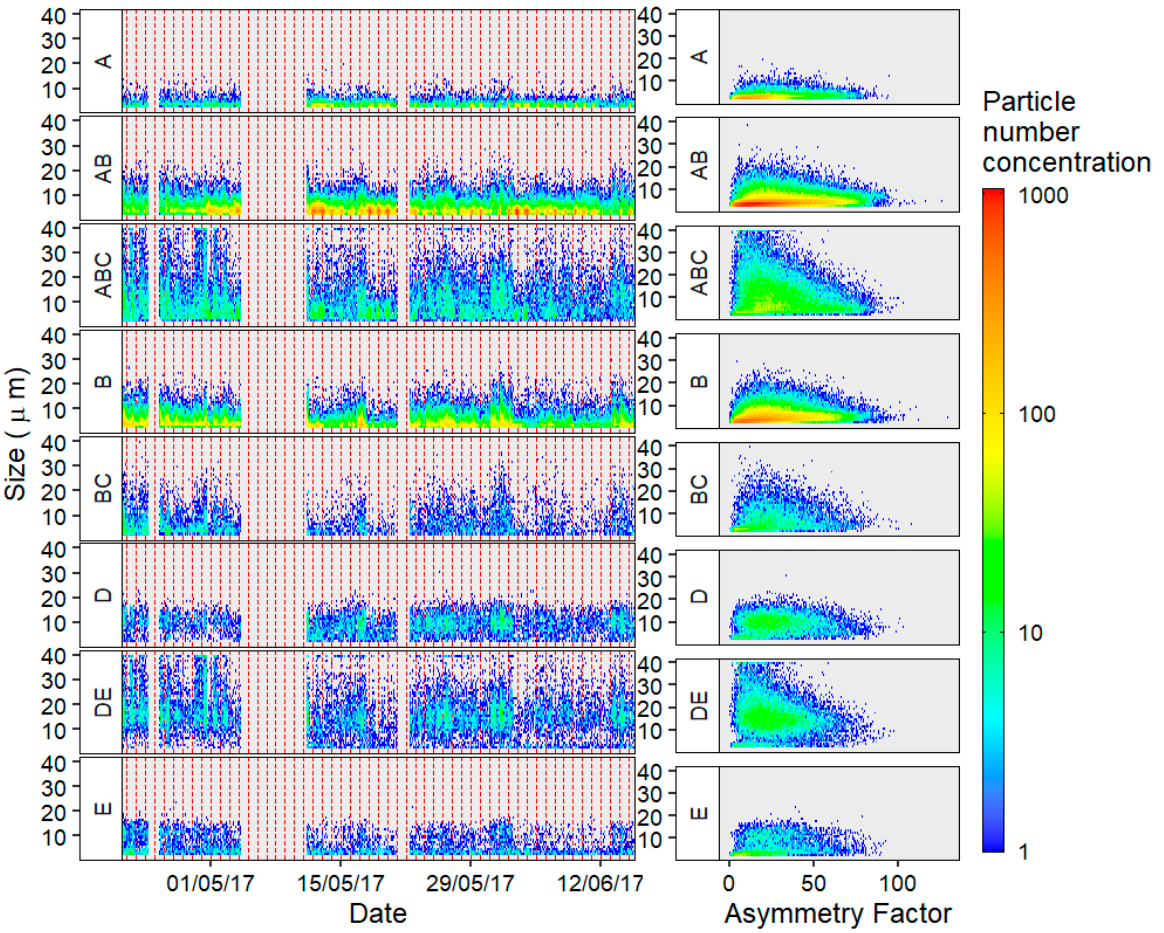
Figure 4. Daily temporal trends (left—where each area within the red dotted line illustrates 1 day) and Size vs. Asymmetry Factor distribution (right) of the largest contributors to the fluorescent particle trends.